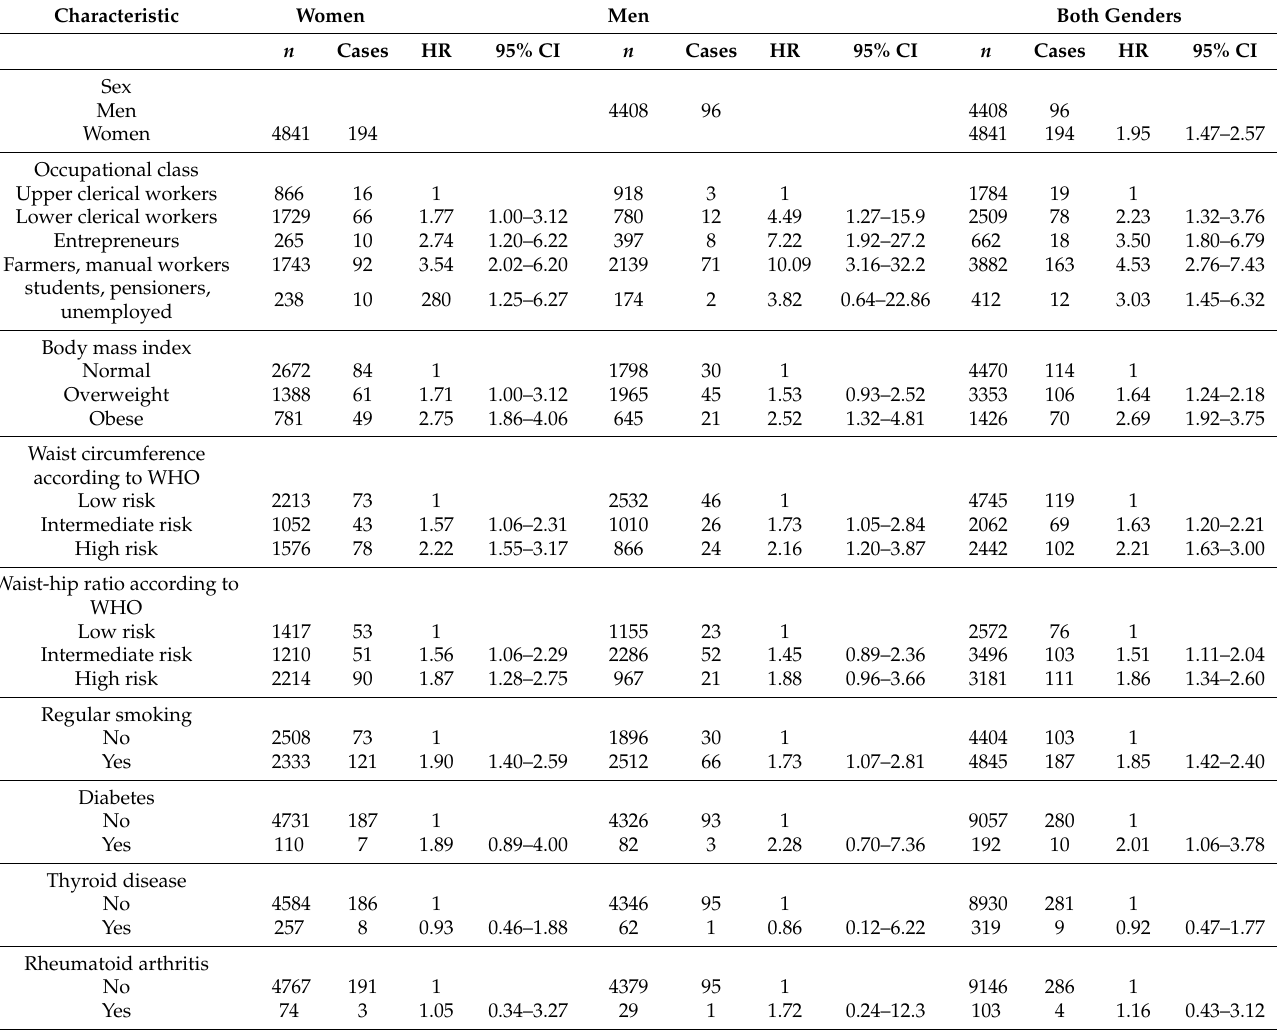
Table 1. Age-adjusted hazard ratios (HR) with 95% confidence intervals (Cl) of diagnosed carpal tunnel syndrome among men, women and both genders combined ( n = 9249). NA = not